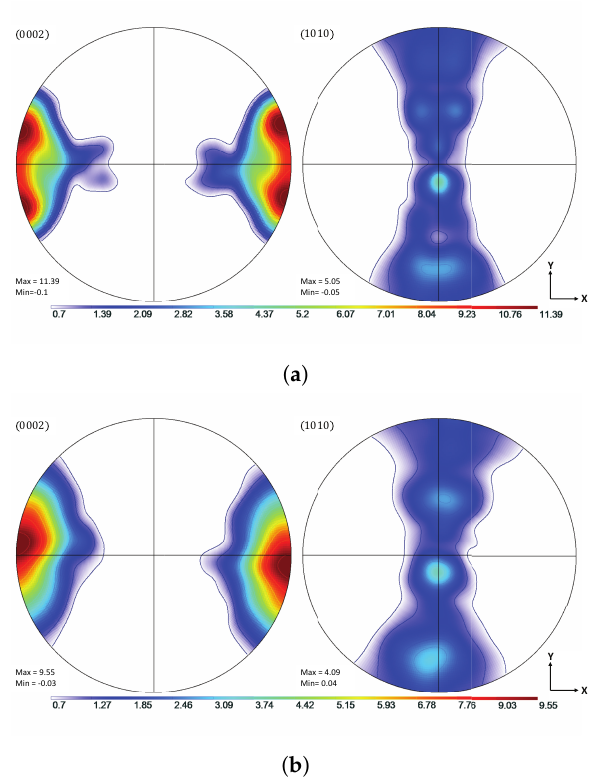
Figure 9. Texture comparison of simulated and experimental textures under IPC load conditions at (cid:101) = 0.12. ( a ) Simulated { 0002 } and { 1010 } pole figures. ( b ) Experimental { 0002 } and { 1010 } pole figures.